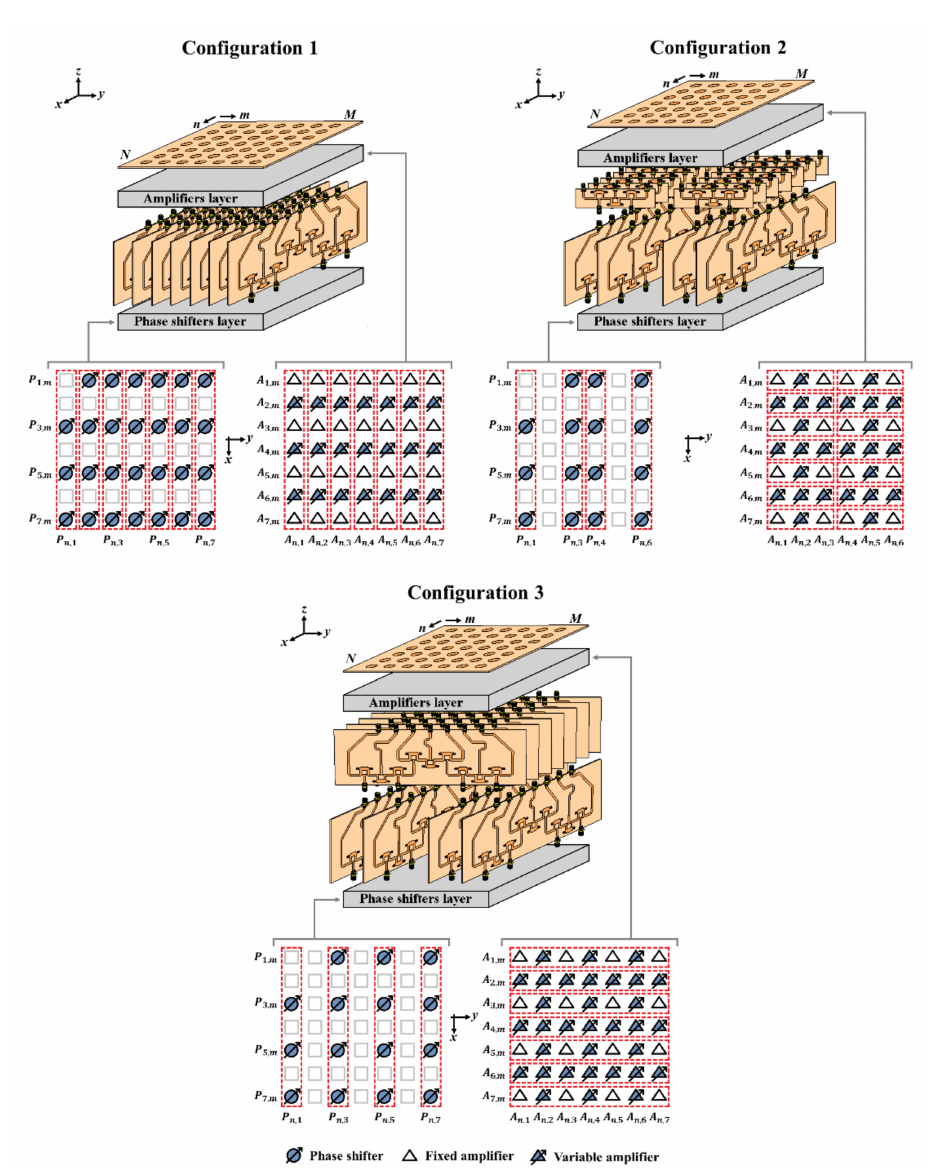
Figure 1. Planar array configurations using blocks of 2 × 3 and 4 × 7 CORPS